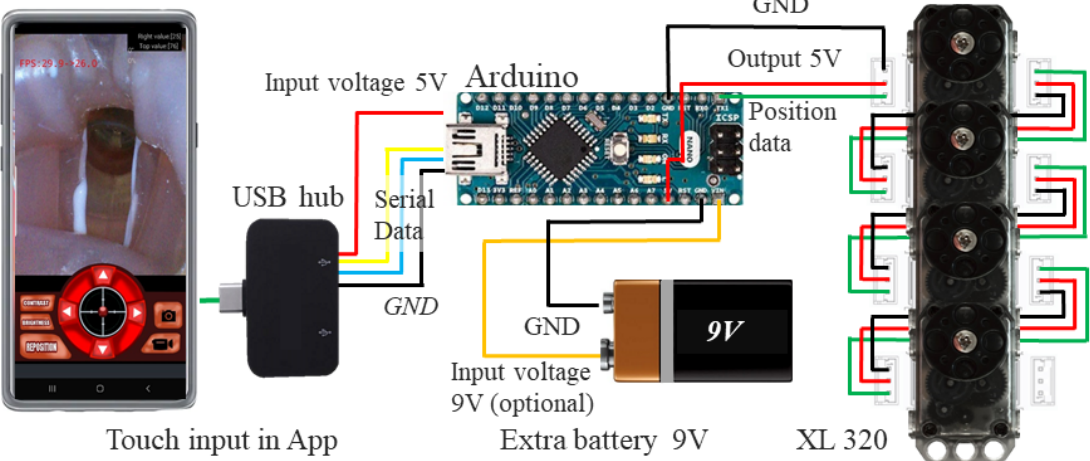
Figure 2. Electric control diagram of the articulation control system. The touch input from a smartphone app is processed into motor control signals using an Arduino processor. The extra battery is optional.